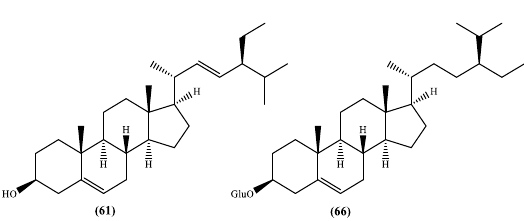
Figure 2. Steroids isolated from the genus Scabiosa (Glu = glucose).